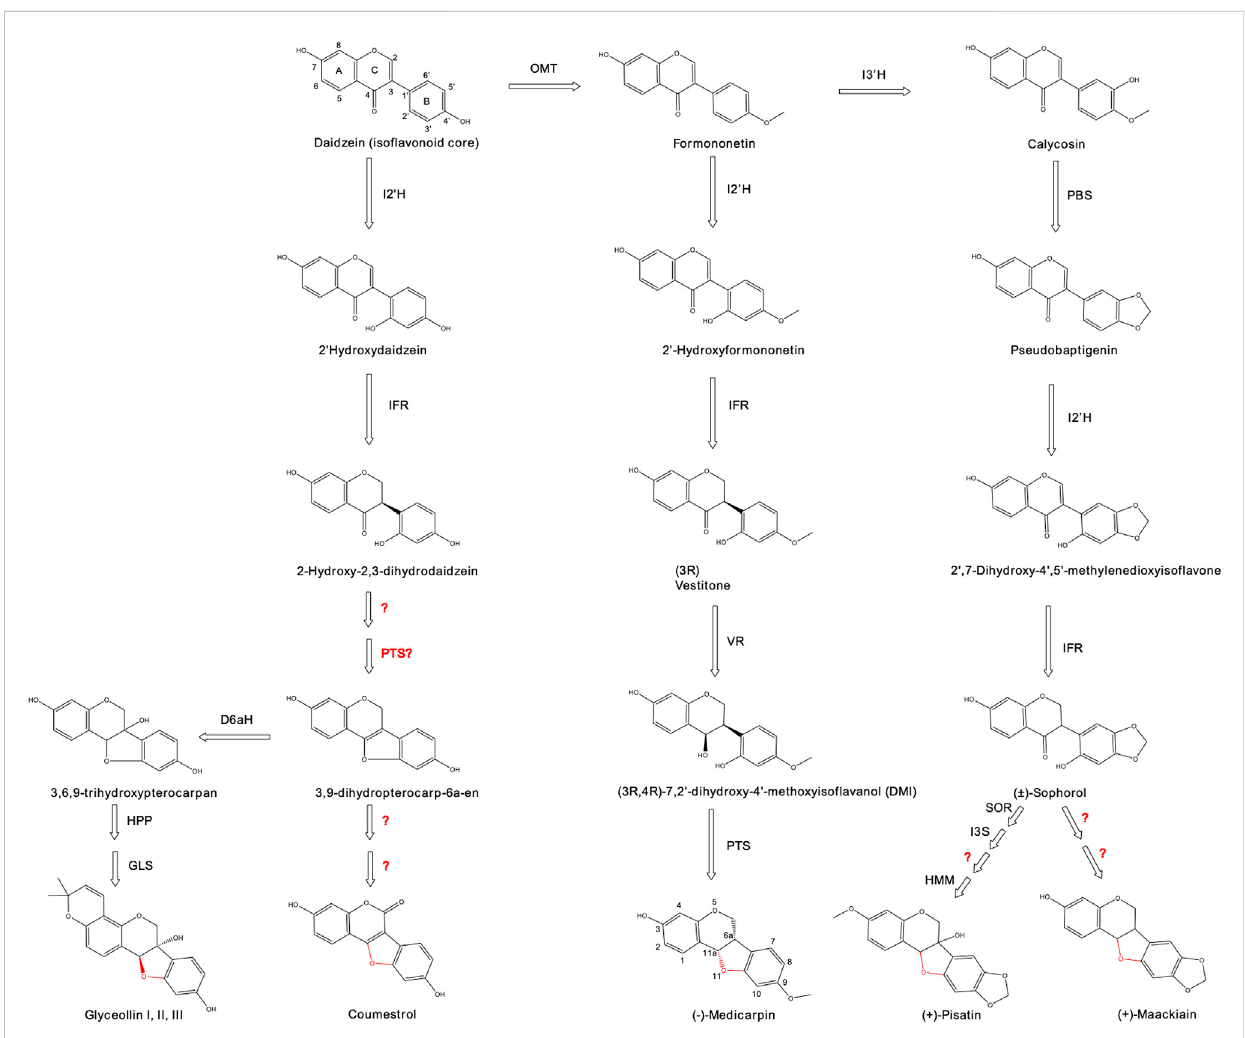
FIGURE 1 Biosynthetic pathway for the production of coumestans and pterocarpans from the precursor, daidzein. Numbers for identifying carbon positions are shownfor daidzein(iso fl avonoid core) and medicarpin (carbon numbering varies with theformation ofthefourth ring). Theformation ofafourth ring between carbons 6 and 11 is highlighted in red. Abbreviations: OMT = iso fl avanone 4 ′ -O-methyltransferase; I3 ′ H = iso fl avone 3 ′ -hydroxylase; I2 ′ H = iso fl avone 2 ′ -hydroxylase; IFR = iso fl avone reductase; PBS = pseudobaptigenin synthase; VR = Vestitone reductase; PTS = pterocarpan synthase; SOR = sophorol reductase; I3S = iso fl av-3-ene synthase; HMM = (+)-6a-hydroxymaackiain 3-O-methyltransferase; DHPH = 3,9-dihydroxypterocarpan 6a-hydroxylase; GLS = glyceollin synthase; HPP = trihydroxypterocarpan prenyltransferase; D6aH = 3,9-dihydroxypterocarpan 6a-hydroxylase. Question marks indicates unknown enzymatic